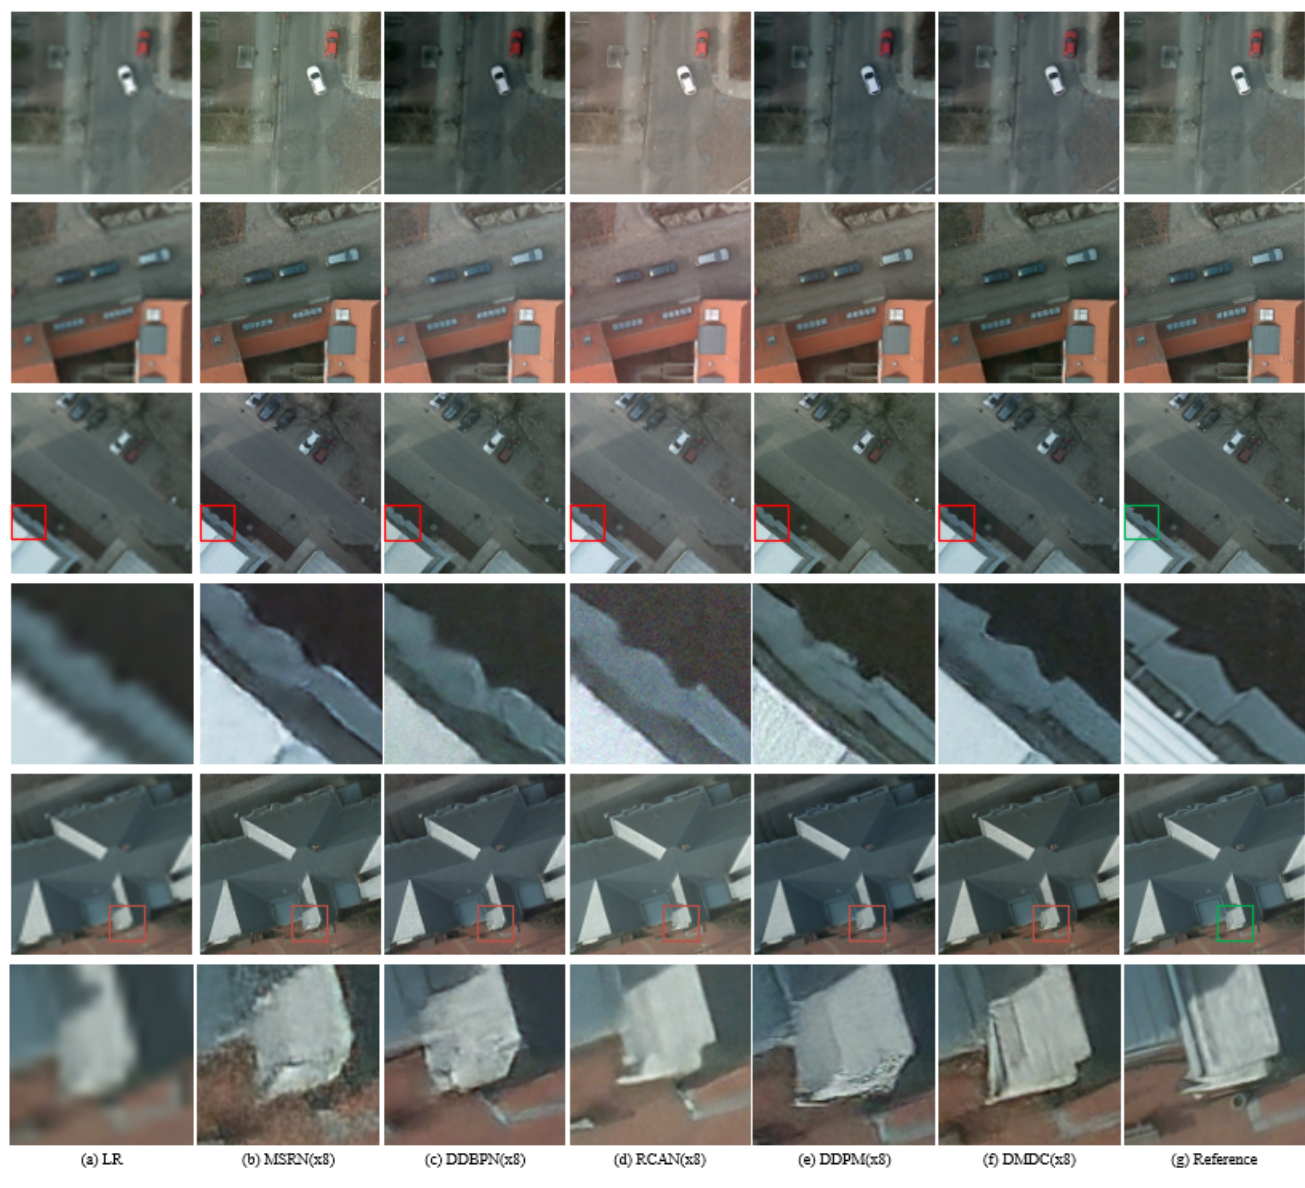
Figure 8. ISPRS-Potsdam dataset × 8 magnification SR qualitative results. From left to right: ( a ) LR image, ( b ) MSRN [58], ( c ) DDBPN [59], ( d ) RCAN [60], ( e ) DDPM [18], ( f ) DMDC (ours), and ( g ) Ref- erence. For detailed comparison, the red rectangle is cropped and its enlarged version is placed in the lower row. Compared to MSRN [58] and RCAN [60], DMDC produces more detailed and contrasting images, avoiding the artifacts encountered by DDBPN [59] and DDPM [18] (e.g., within the red boxes in row 2 and row 3, the detail recovery at the edge of the house), and maintain consistency with the ground-truth. Zoom-in for better